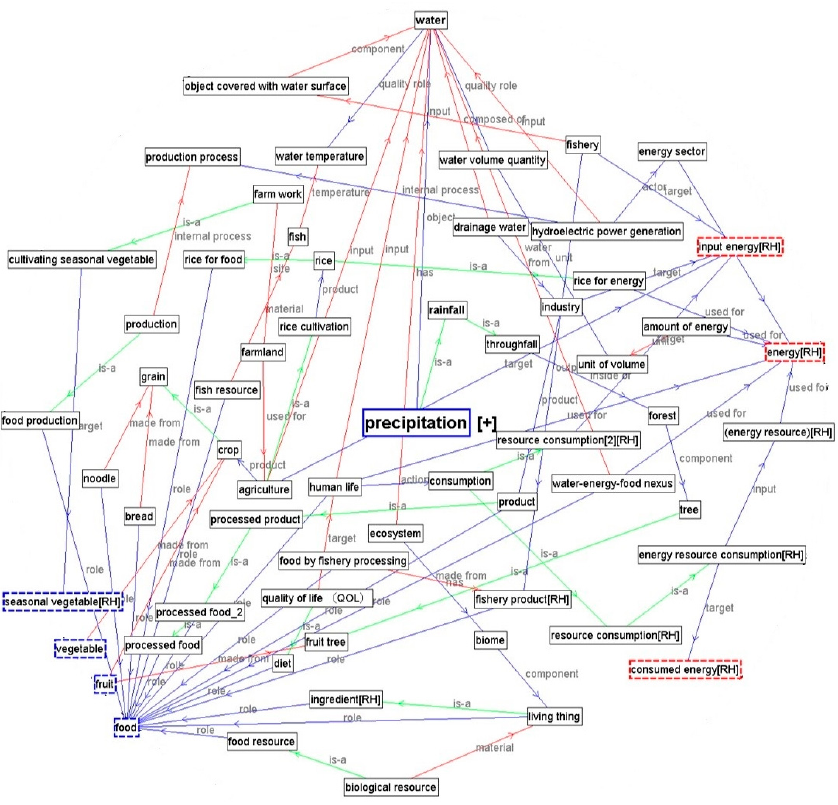
Figure 8. The “precipitation”–energy–food nexus system map.